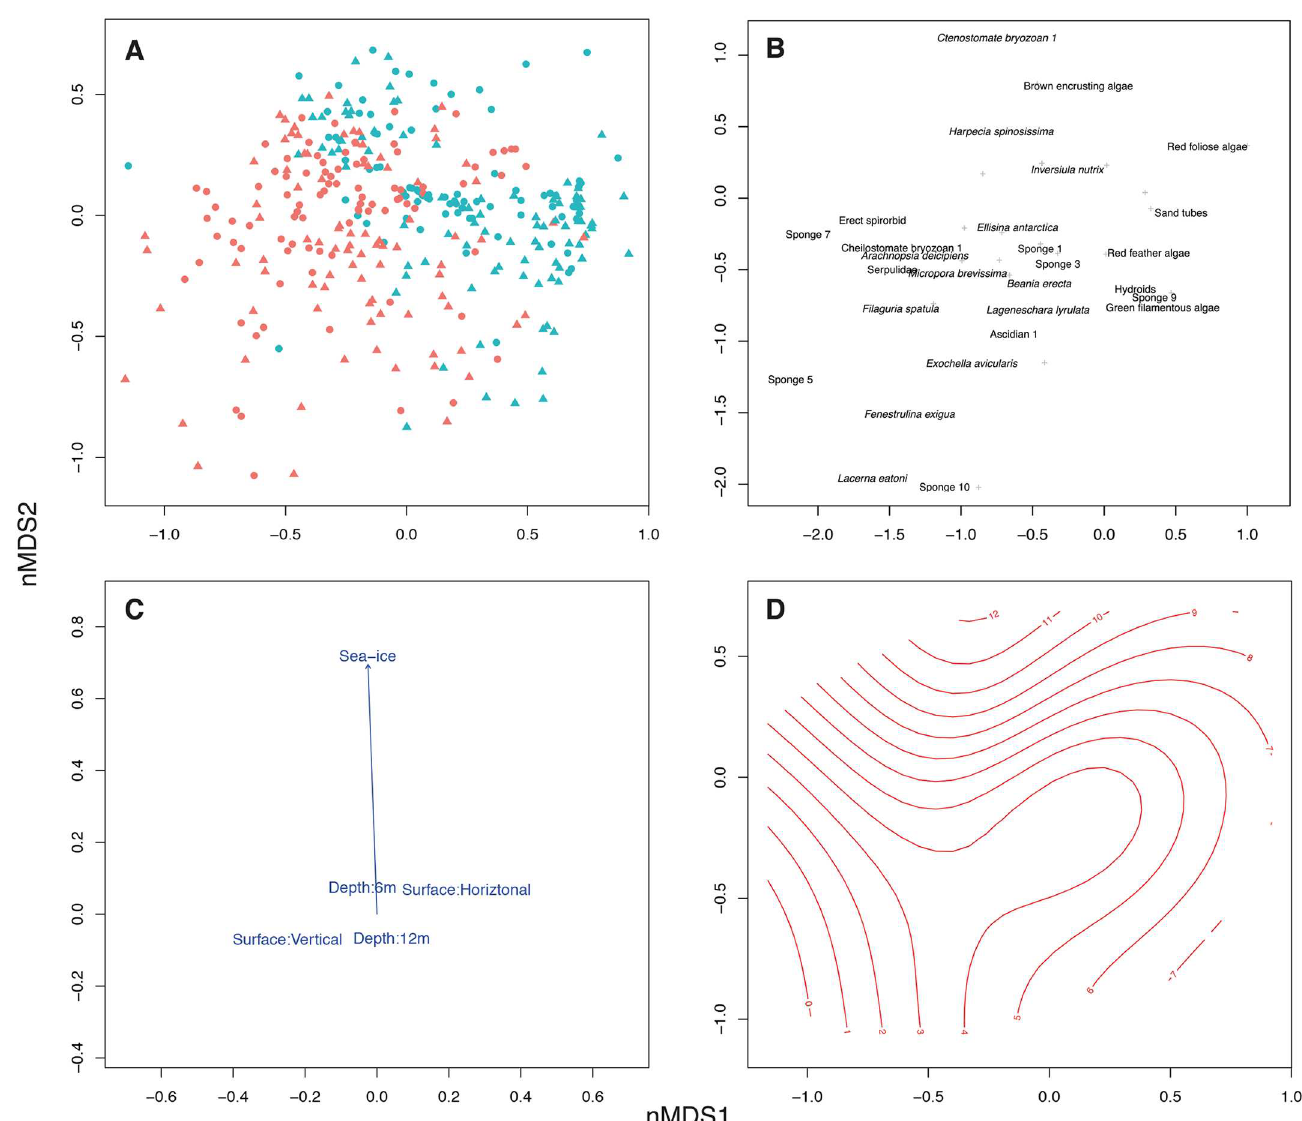
Fig 4. Multivariate patterns in boulder communities. (A) Multidimensional scalingplot (nMDS) based on Bray-Curtis similarity, showingboulder communitiesas points. Shapes represent depths (circles = 6 m, triangles= 12 m), coloursrepresent orientations(red = Vertical, green = Horizontal). Axes are scaled such that 1 unit equatesto a doublingin dissimilarity betweensamples. (B) Correlations betweenspecies and nMDS axes. Where species positionsoverlap, the more abundantspecies is displayedby name and other speciesappearas grey crosses. (C) Vector correlationbetween continuousenvironmental covariate (sea-icerank) and nMDS axes, and positionof centroids of factor levels. (D) Contourplot of sea-icerank, fitted by GAM to nMDS axes.